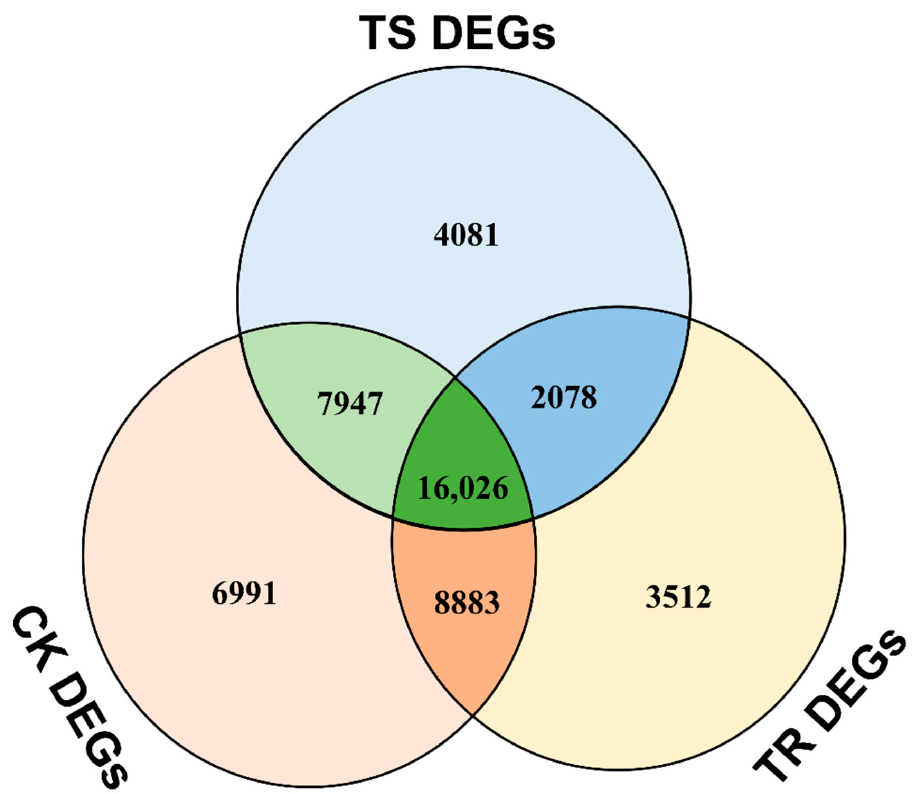
Figure 5. Venn diagrams of CK DEGs, TS DEGs and TR DEGs. CK: all DEGs between uninoculated resistant clonal line and the susceptible clonal line at four time points; TS: all DEGs between the uninoculated and inoculated groups of susceptible clonal line at four time points; TR: all DEGs between the uninoculated and inoculated groups of resistant clonal line at four time